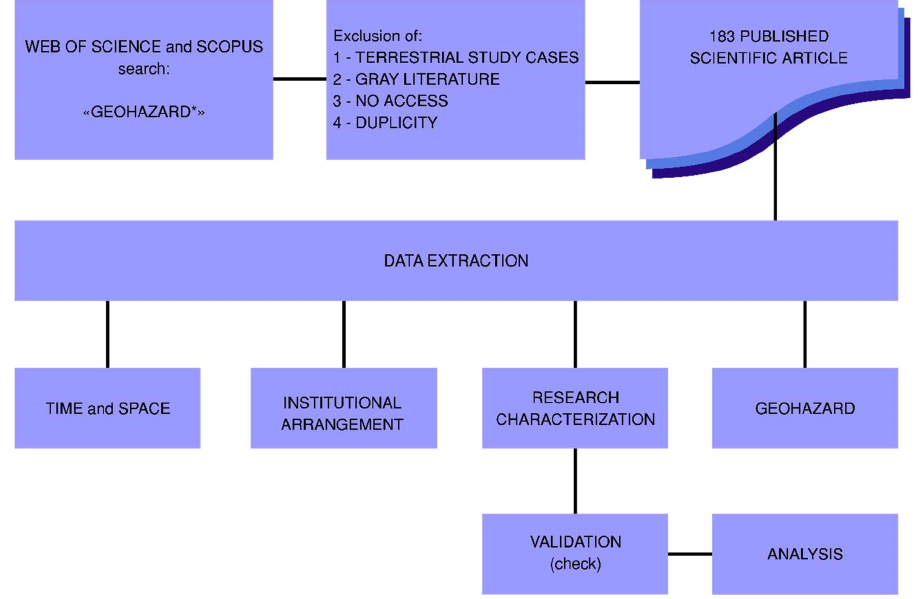
Figure 1. Methodological flowchart applied to the definition of the data set, extraction, and analysis of the information. the